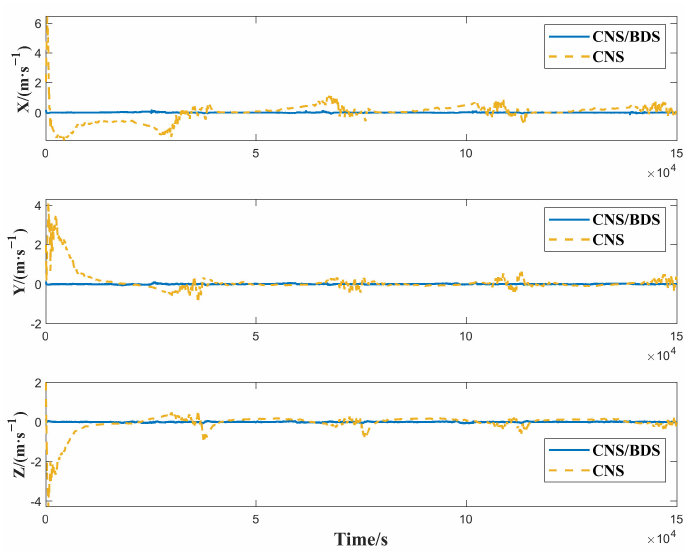
Figure 9. Velocity error in three